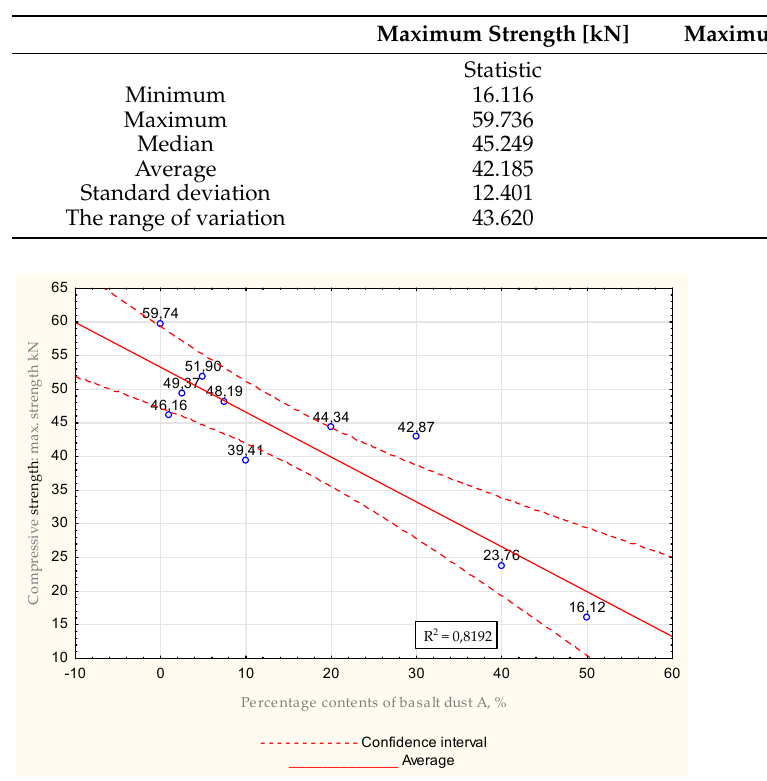
Figure 21. Average values received during compressive strength tests for water − mix ratio = 0.6, maximal strength.